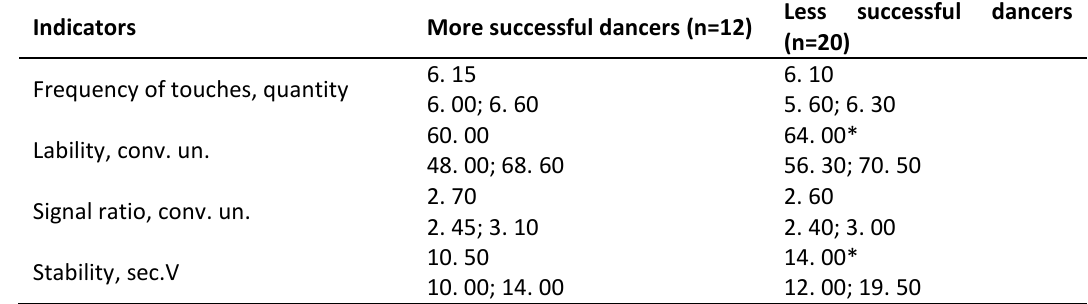
6. 15 6. 00; 6. 60 60. 00 48. 00; 68. 60 2. 70 2. 45; 3. 10 10. 50 10. 00; 14. 00